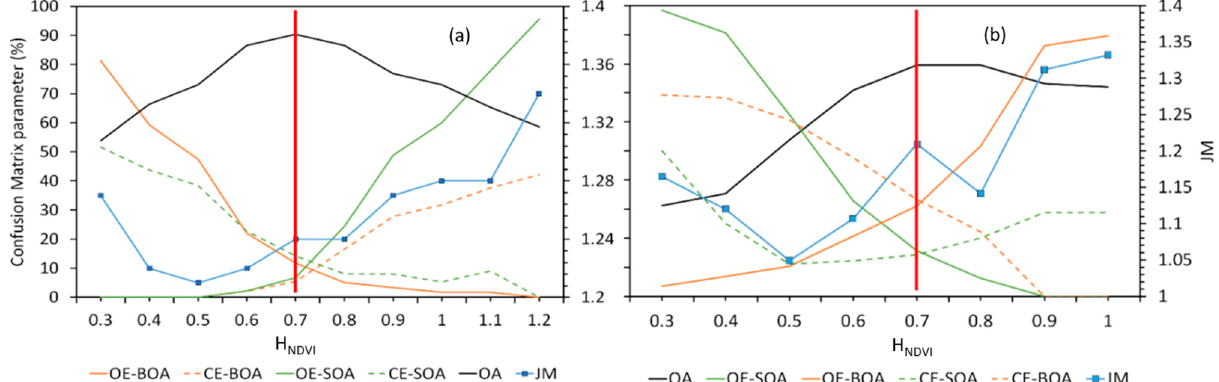
Figure 9. Accuracy parameters used to select the NDVI entropy threshold ( H NDVI , red vertical line) to generate a binary classification of rural production systems. ( a ) Agriculture LULC accuracy. ( b ) Pasture LULC accuracy. Omission and Commission Errors (OE and CE) produced during Business Oriented Agriculture systems classification (OE-BOA and CE-BOA) are marked by solid and dotted orange lines, respectively. Omission and Commission Errors generated during Subsistence Oriented Agriculture systems classification (OE-SOA and CE-SOA) are marked by solid and dotted green lines. The overall accuracy (OA) is represented by solid black lines and the Jeffries–Matusita (JM) values are depicted by blue lines.